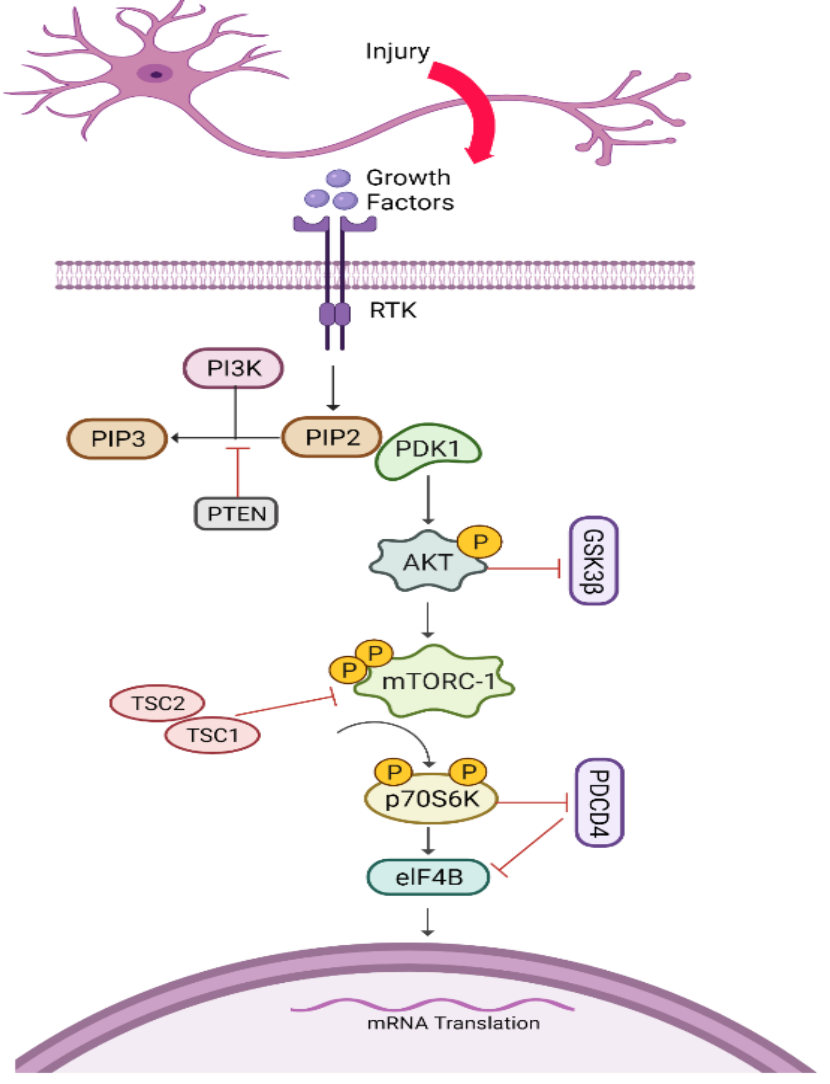
Figure 6. AKT/mTORC1/p70S6K pathway. After nerve injury, several growth factors participate to initiate a cascade of reactions for axonal growth. They bind to receptor tyrosine kinase and activate PI3K/AKT-mediated mTORC1, which further phosphorylates S6. pS6 stimulates elG4B to prevent muscle atrophy and thus increases axon regeneration. RTK: receptor tyrosine kinase; PI3K: phosphatidylinositol-3-kinase; PIP3: phosphatidylinositol (3,4,5)-trisphosphate; PIP2: phosphatidylinositol 4,5-bisphosphate; PDK1: pyruvate dehydrogenase kinase 1; PTEN: phosphatase and tensin homolog; AKT: protein kinase B; Gsk3β: glycogen synthase kinase; mTORC-1: mammalian target of rapamycin; TSC1: hamartin; TSC2: tuberin; Pdcd4 : programmed cell death 4 gene. It was seen that mTOR increases axon regeneration in the PNS through the deletion of negative regulators, including PTEN, hamartin (TSC1), and tuberin (TSC2) [4,57]. In- terestingly, TSC2 inhibits axon growth by inactivating Rheb (Ras homolog enriched in the brain), which is a GTP-binding protein. Typically, activated Rheb acts as a direct ac- tivator of AKT-mediated mTORC1 signalling as mentioned by in vivo study of the is- chemic spinal cord injury model [141]. Indeed, the balance of inhibitors and activators determines the pace of growth; it is necessary to target these inhibitors in order to offer the optimum regenerative environment for damaged neurons. PTEN knockdown or long-term inhibition, on the other hand, has been linked to neoplasia, including malig- nant glial tumors and hamartomas, according to prior research [63,100,142]. TSC-1 and TSC-2, which stimulates axonal growth, can be inhibited by activated AKT. Conclusively,